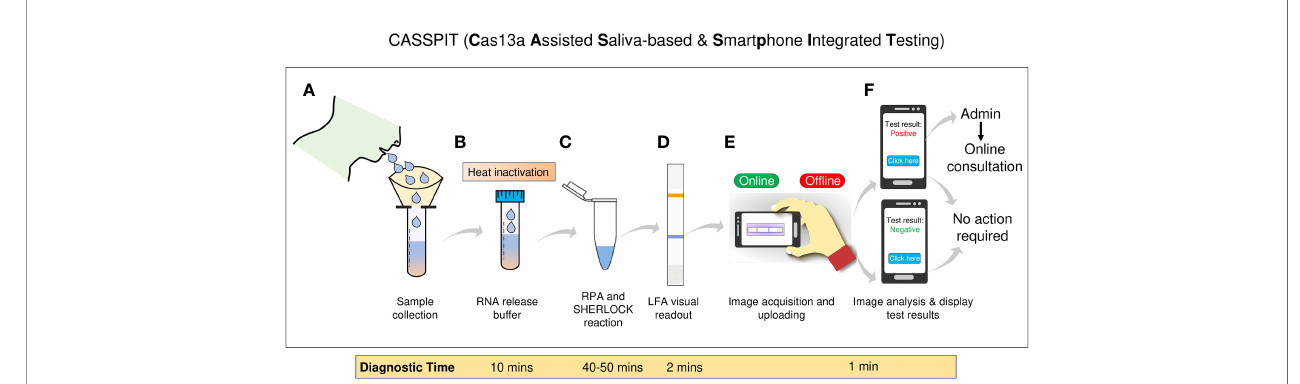
FIGURE 5 | Schematic representation of the CASSPIT work fl ow (A) Self-collection of saliva samples by the patient in a sample collection tube which contains the RNA release chemical agents. (B) The samples will be subjected to heat inactivation to inactivate the virus and simultaneously release the viral RNA. (C) Released RNA will be transferred into one-pot or two-pot SHERLOCK master mix tube to amplify the signal with RT-RPA and detect the target by Cas13a. After target detection, activated Cas13 will cleave the reporter. (D) Paper-strips will be immersed in the SHERLOCK reaction mix and subjected to LFA to obtain the visual results. (E) Using mobile phone camera, images of the paper-strip will be captured and subjected to processed using the app. Test results will be provided based on the signal detection in Test and Control lanes of the paper-strip. (F) Further the app will have a provision to store the images, test results and help with online assistance if needed. The overall work fl ow with saliva as test samples is named as C as13 A ssisted S aliva-based & S martphone I ntegrated T esting